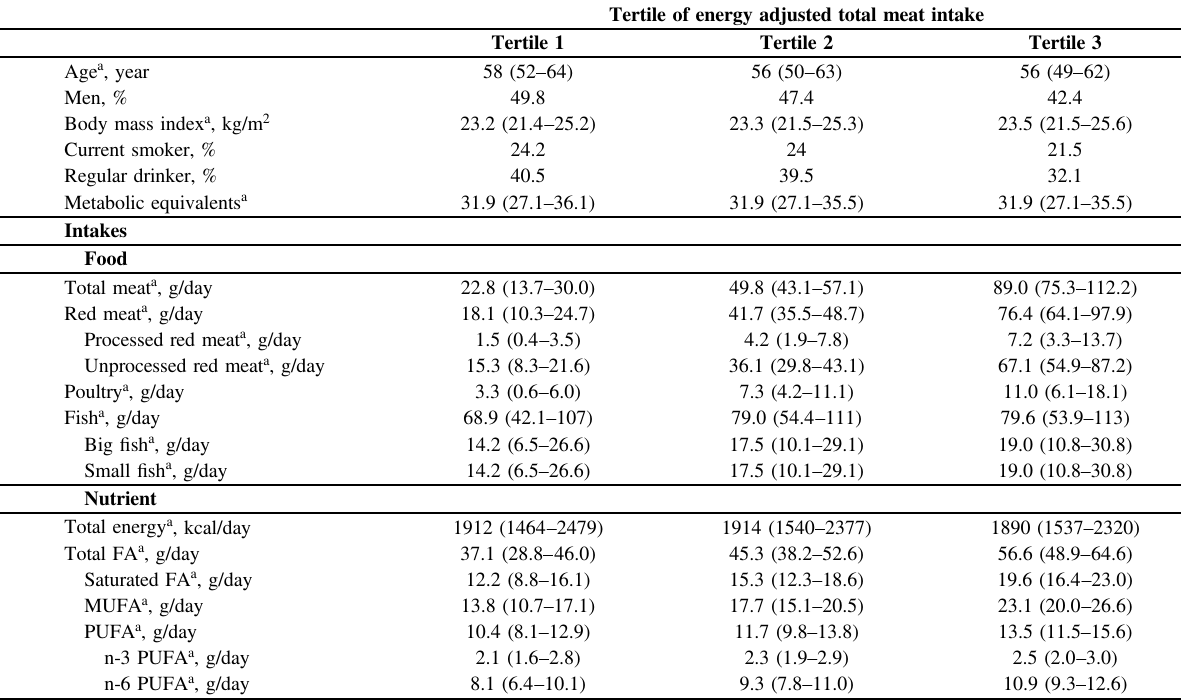
Table 1 Participant Baseline Characteristics according to the Japan public health center based prospective study cohort